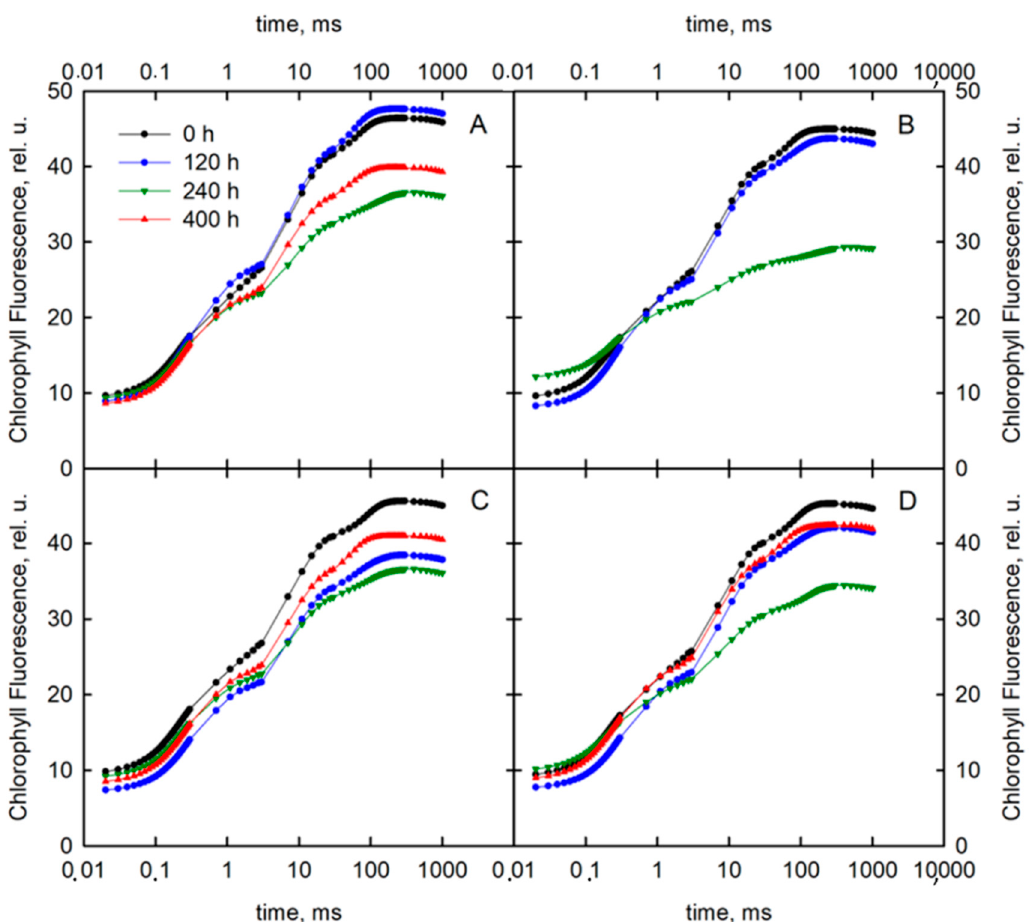
Figure 1. Induction curves of chlorophyll a fluorescence of perennial ryegrass varieties (Roadrunner and Nira) grown under different field water capacities of soil (50 and 30% field water content (FWC)) at 0, 120, 240, and 400 h after stress application. ( A ) Roadrunner under 50% FWC, ( B ) Roadrunner under 30% FWC, ( C ) Nira under 50% FWC, ( D ) Nira under 30% FWC. n = 6 relative units. rel. u., relative units.